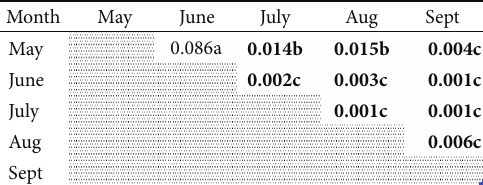
Figure 8: Summary of 𝑃 -valueresultsfor Pairwisecomparisons of insect assemblages between Months. Significant differences arehighlighted in bold, and differences in significance threshold are highlighted by a different letter.